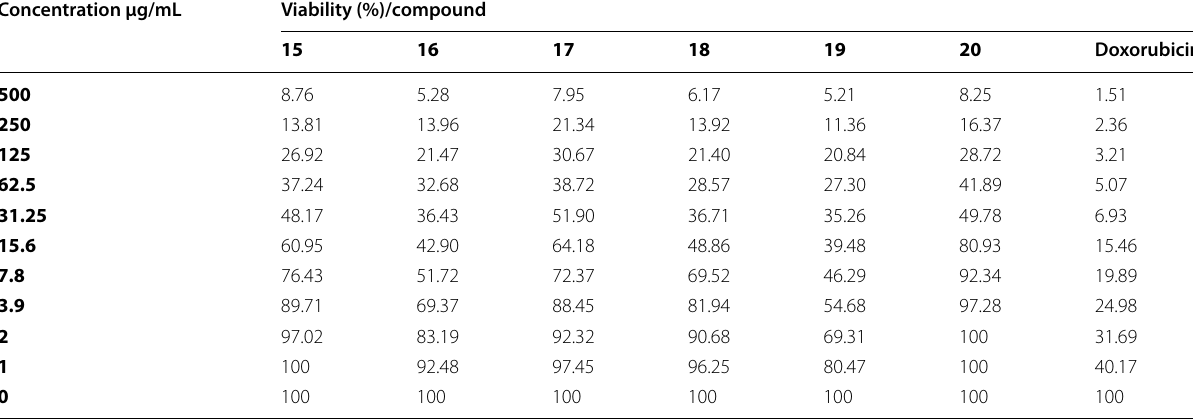
Table 6 Cytotoxicity of compounds 15, 16, 17, 18, 19, 20 and Doxorubicin against breast carcinoma cell line MCF-7 Concentration µg/mL Viability